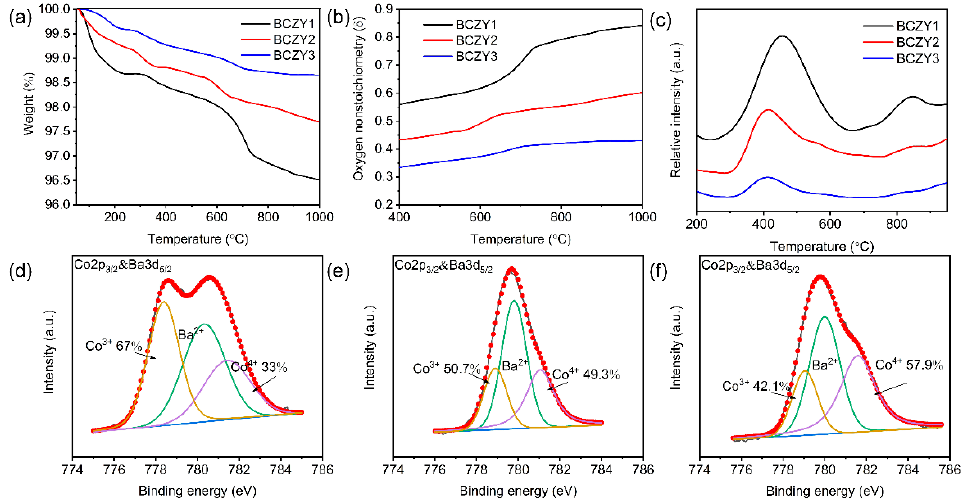
Figure 4. ( a ) TGA curves; ( b ) oxygen vacancy concentration; ( c ) O 2 -TPD curves of BCZY1, BCZY2 and BCZY3; Co 2p and Ba 3d XPS spectra of ( d ) BCZY1, ( e ) BCZY2 and ( f ) BCZY3.